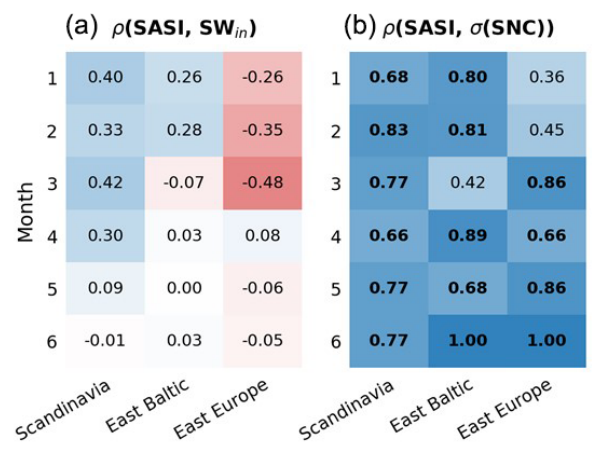
Figure 7. Pearson correlation between SASI and shortwave radia- tion (a) and SASI and standard deviation of snow cover (b) calcu- lated across RCMs for the three regions – Scandinavia, East Baltic and East Europe – for the months of January to June during 1986– 2015. The values represent the variable (shortwave radiation or vari- ability in snow cover) to which the inter-model variability in SASI is predominantly related. Bold values indicate statistical significance at the 0.05 level (two-tailed p